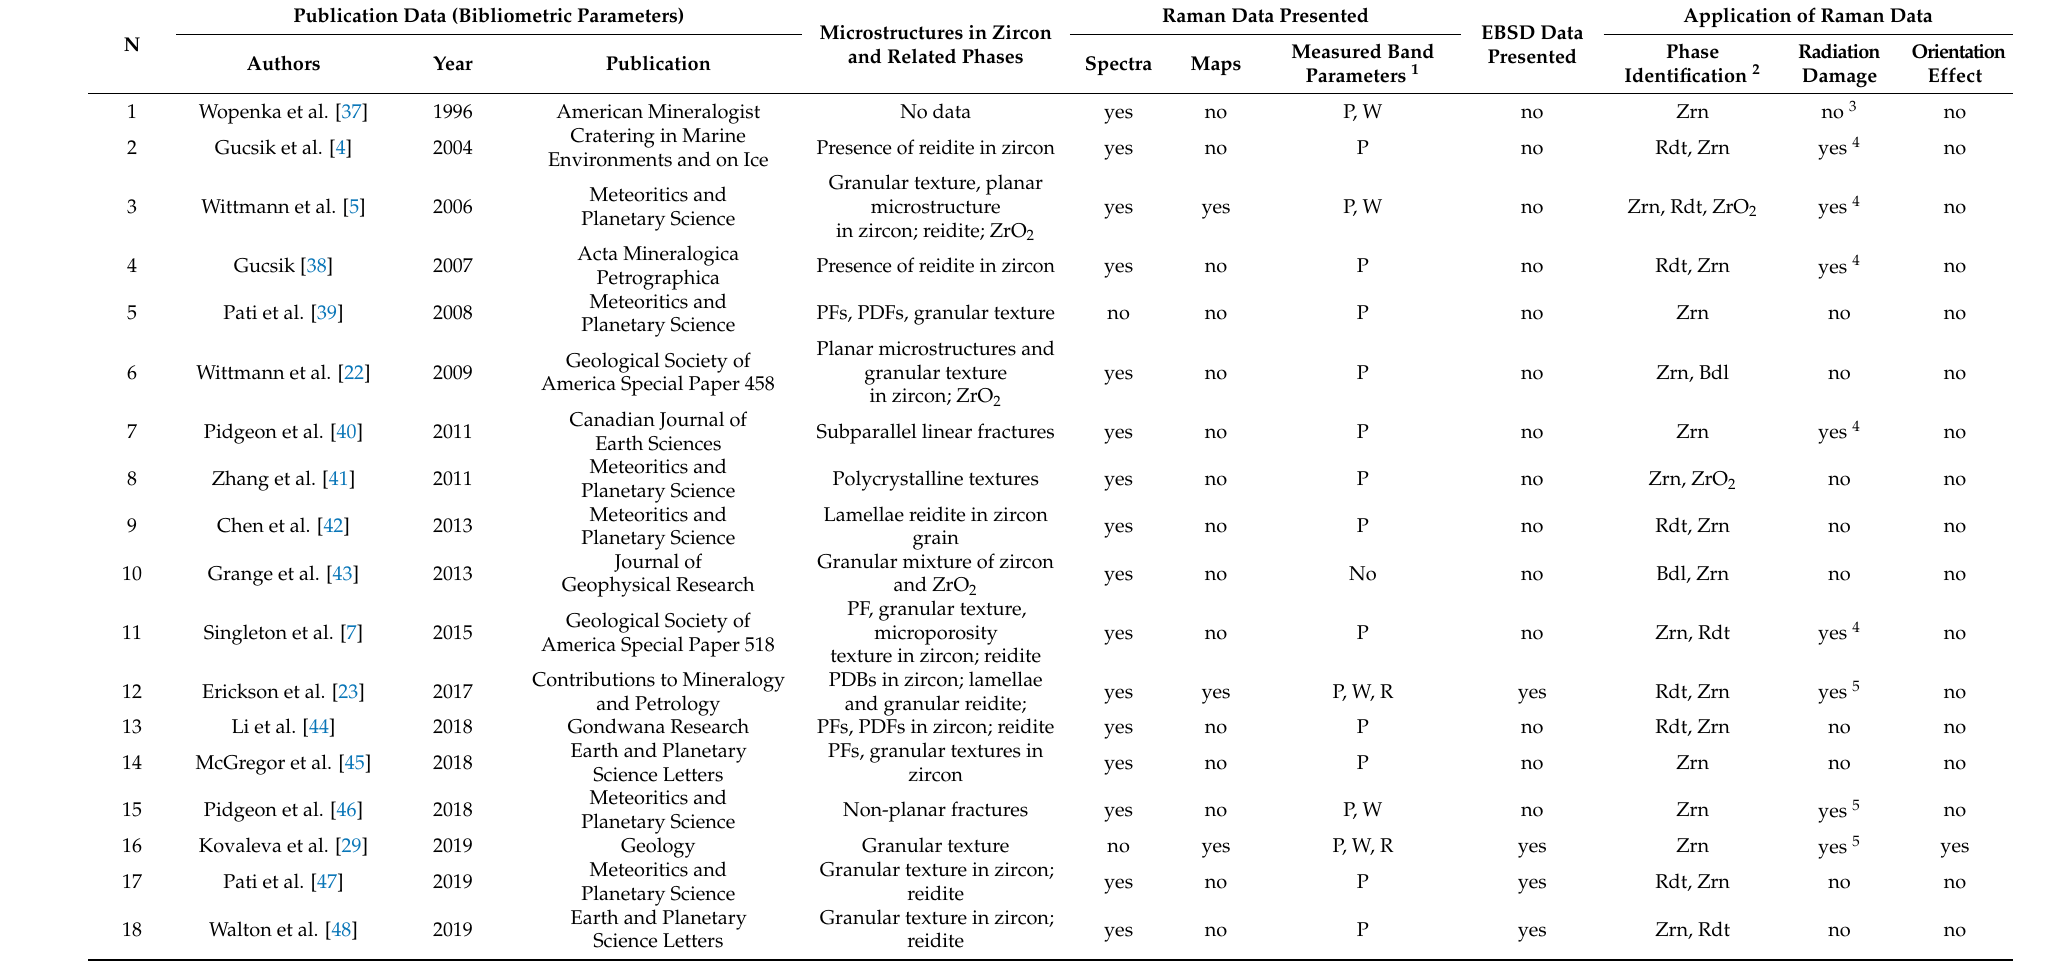
Table 2. Results of the literature search (search: 5 April 2022). Studies are listed